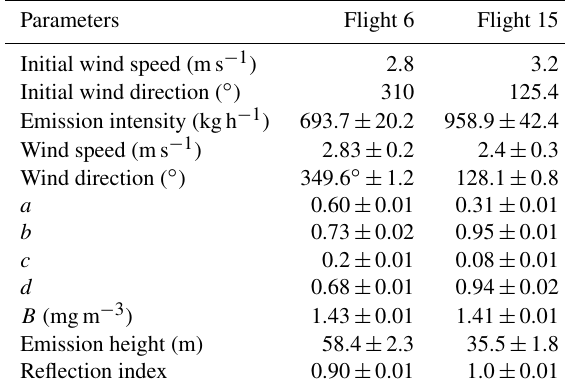
Table 1. Results calculated by the GA-IPPF